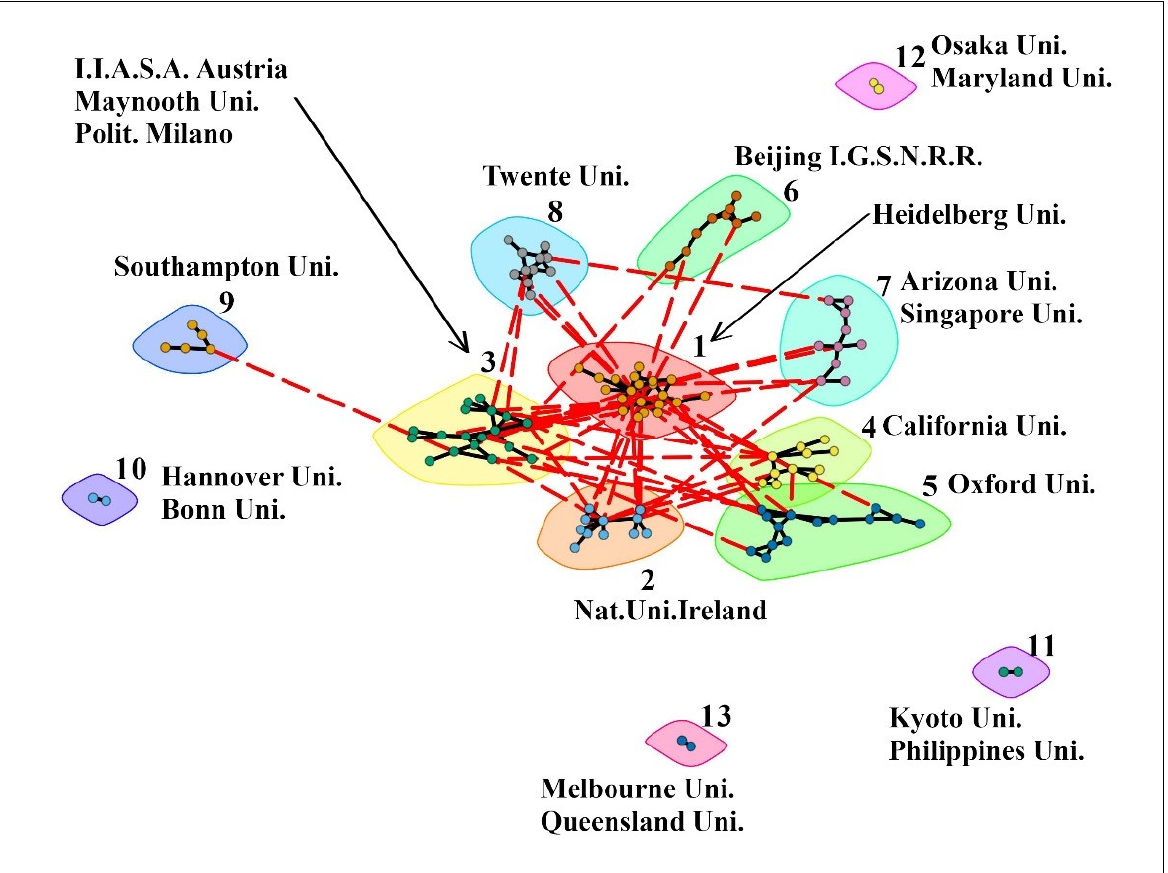
Figure 3. Collaboration network among the 190 most productive institutes, showing that there were eight large- to medium-sized and five small subnetworks. Clusters of institutes are highlighted by different coloured polygons. The title of the clusters is given by the institution with the higher degree of centrality (more than one in case of ex aequo). Within each cluster, there was no homogeneity on institute nationality. (1) Heidelberg University, Germany; (2) National University of Ireland; (3) Austria International Institute for Applied Systems Analysis; Maynooth University,